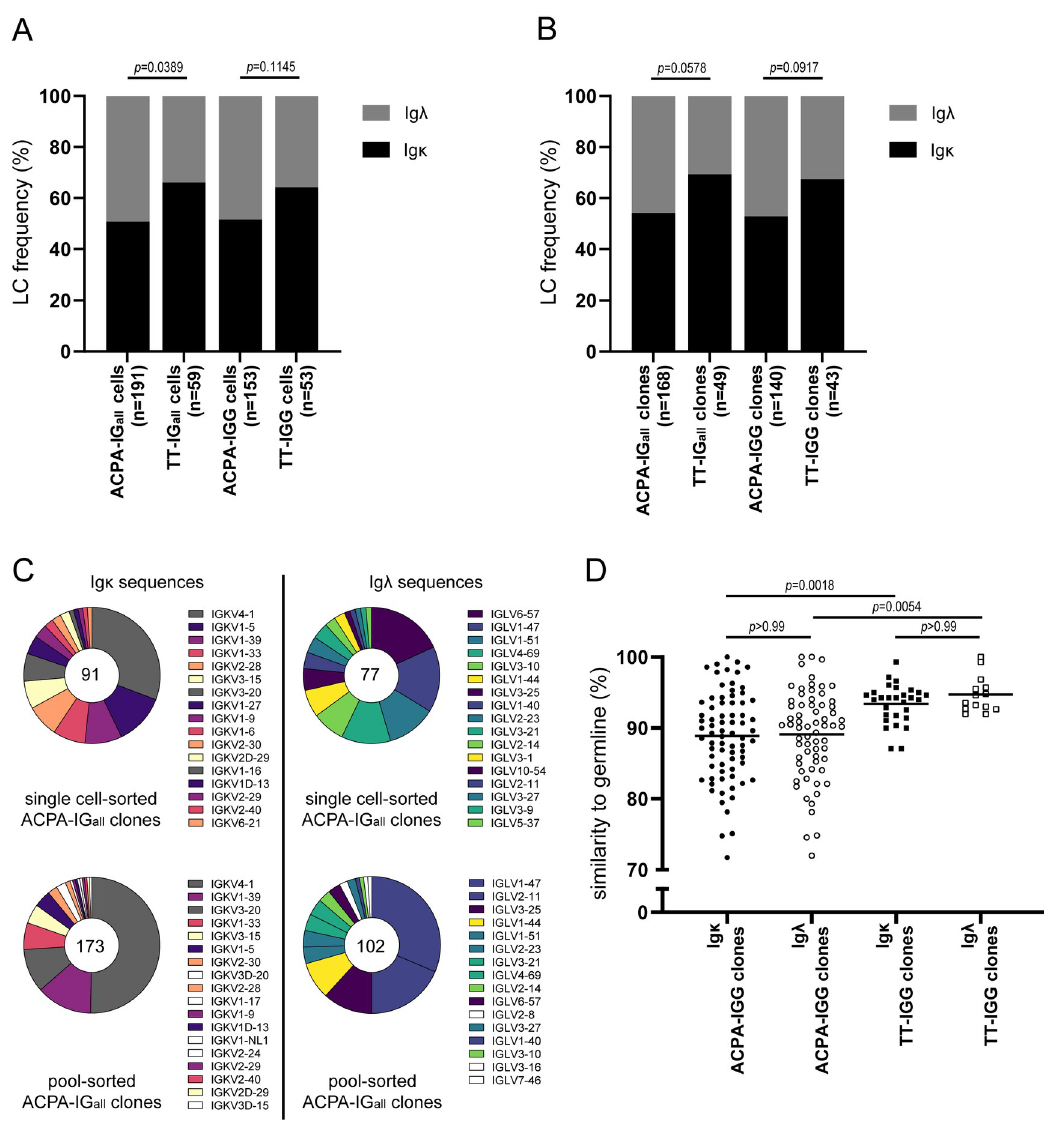
Fig 3. Ig κ and Ig λ frequency and characteristics in BCR sequences of citrullinated antigen- and TT-binding B cells. CD19 + CD20 + citrullinated antigen-binding B cells (derived from 19 patients) or TT-binding B cells (derived from 4 out of 19 patients) were single cell FACS-sorted and cultured for 10–13 days. Single cell-derived Ig all and IgG sequences were analyzed for Ig κ and Ig λ frequency based on sequences from A) all single cells and B) individual clones (defined as identical V-gene+J-gene +CDR3(AA)) to exclude bias due to clonal expansion. Data were statistically analyzed with Chi square test and Holm-Bonferroni correction for multiple comparisons. C) V-gene repertoire of single cell- and pool-sorted ACPA-Ig κ clones (left panels) and ACPA-Ig λ clones (right panels). V-genes, which were not present in single cell-sorted ACPA-LC clones, were colored white in the pie charts of pool-sorted ACPA-LC clones. D) Mutation rate of Ig κ and Ig λ sequences in citrullinated antigen- and TT-binding B cells. Data was statistically analyzed with One-way ANOVA and Holm-Bonferroni correction for multiple comparisons.